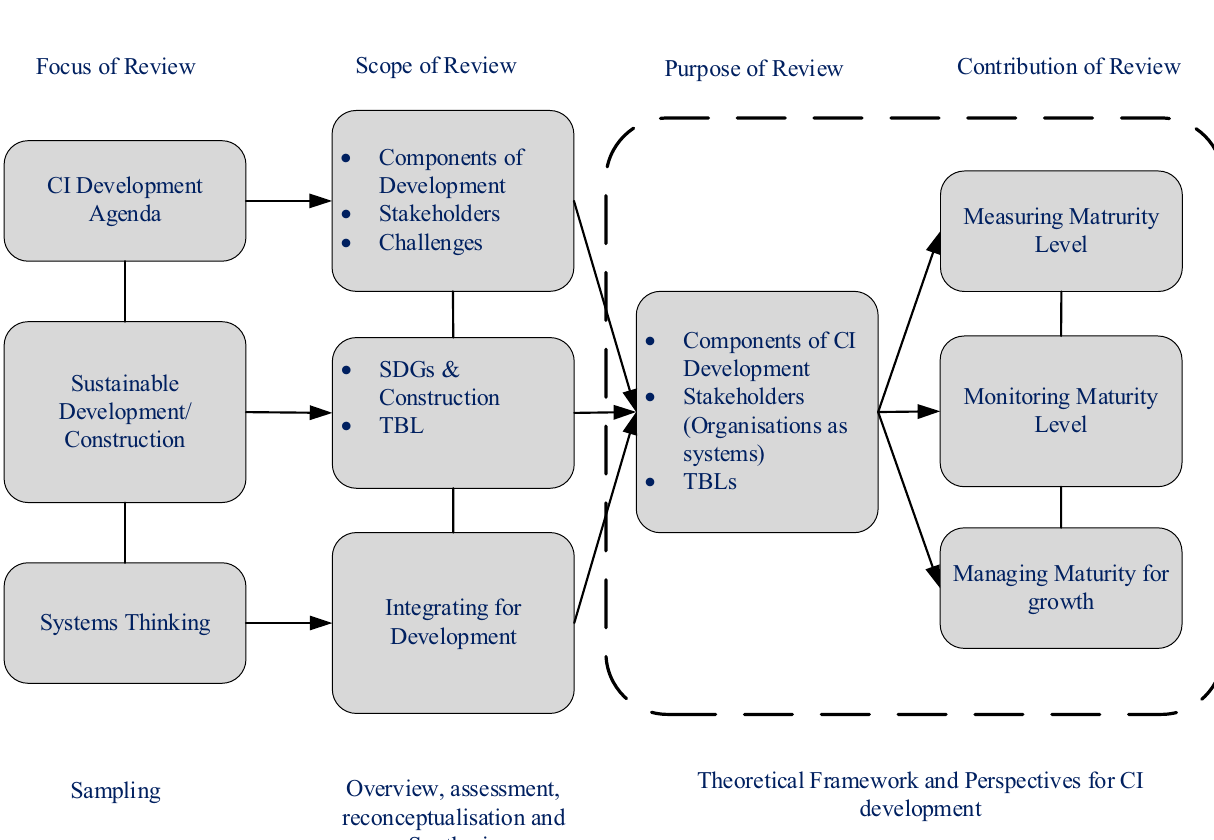
Fig.1 Methodological framework for the